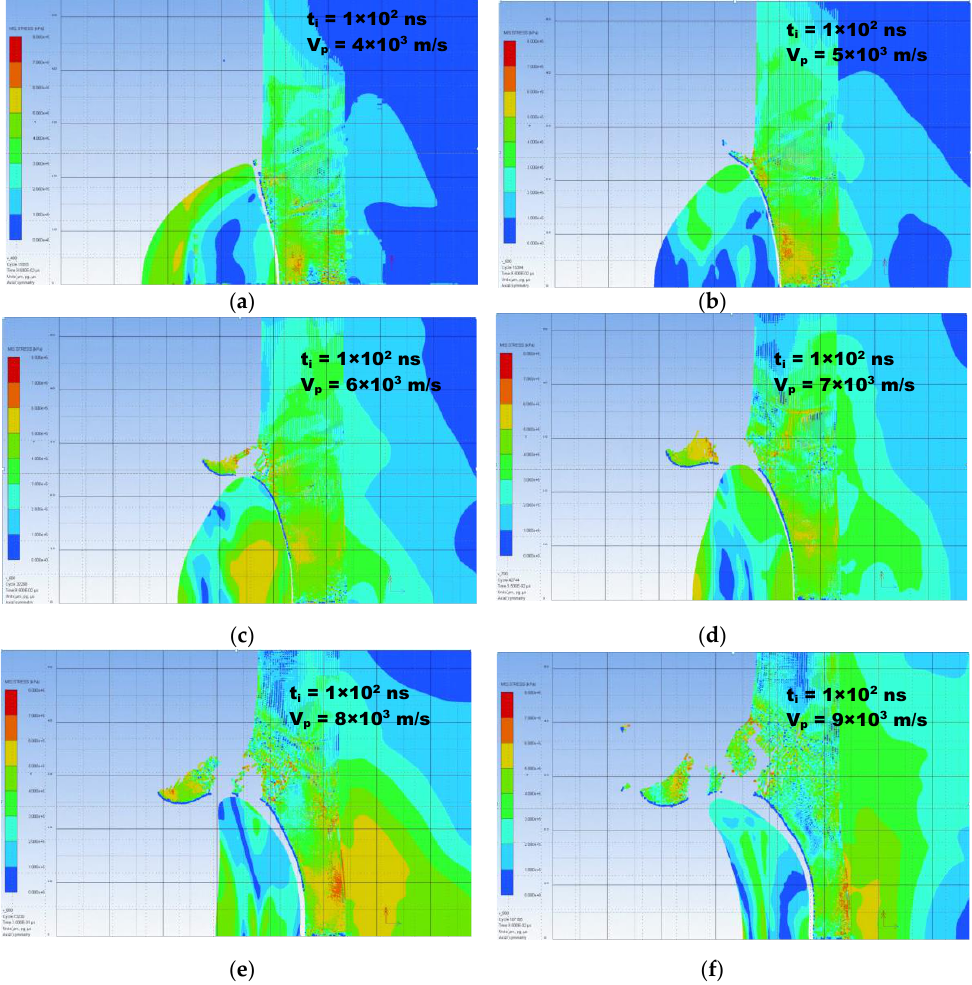
Figure 13. ( a ) Calculated cross-sections of a titanium particle after 100 [ns] from its impact onto a 7075 aluminium alloy plate as a function of the incident particle velocity: ( a ) 400 m/s, ( b ) 500 m/s, ( c ) 600 m/s, ( d ) 700 m/s, ( e ) 800 m/s, and ( f ) 900 m/s.